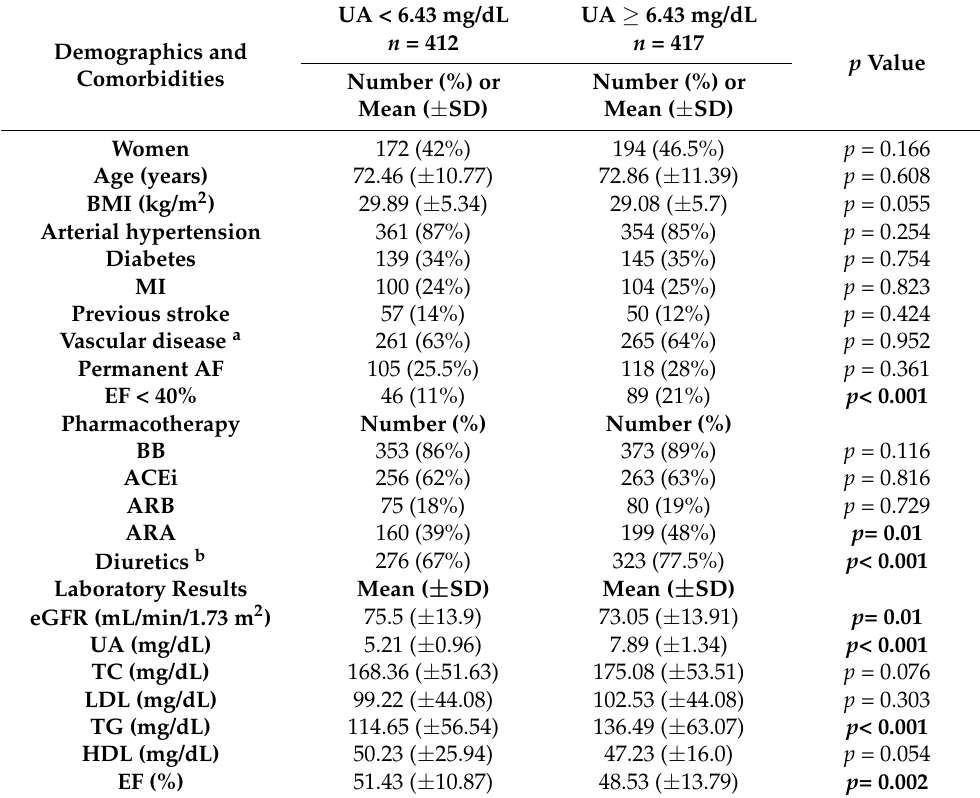
Figure 3. A receiver operating characteristic curve shows the prognostic value of UA concentration for predicting which patients will have an ejection fraction < 40%. The cutoff value (6.69 mg/dL) was identified with the Youden index method. AUC: area under the curve. Table 4. Comparison of groups, based on whether the UA concentration was above or below the median value in the study population (6.43